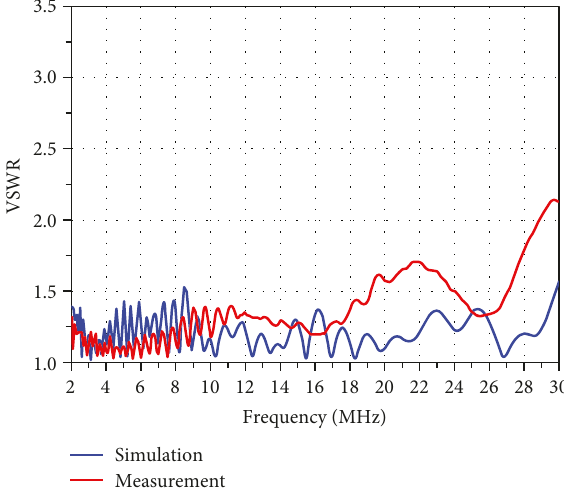
Figure 12: The variation curve of VSWR with